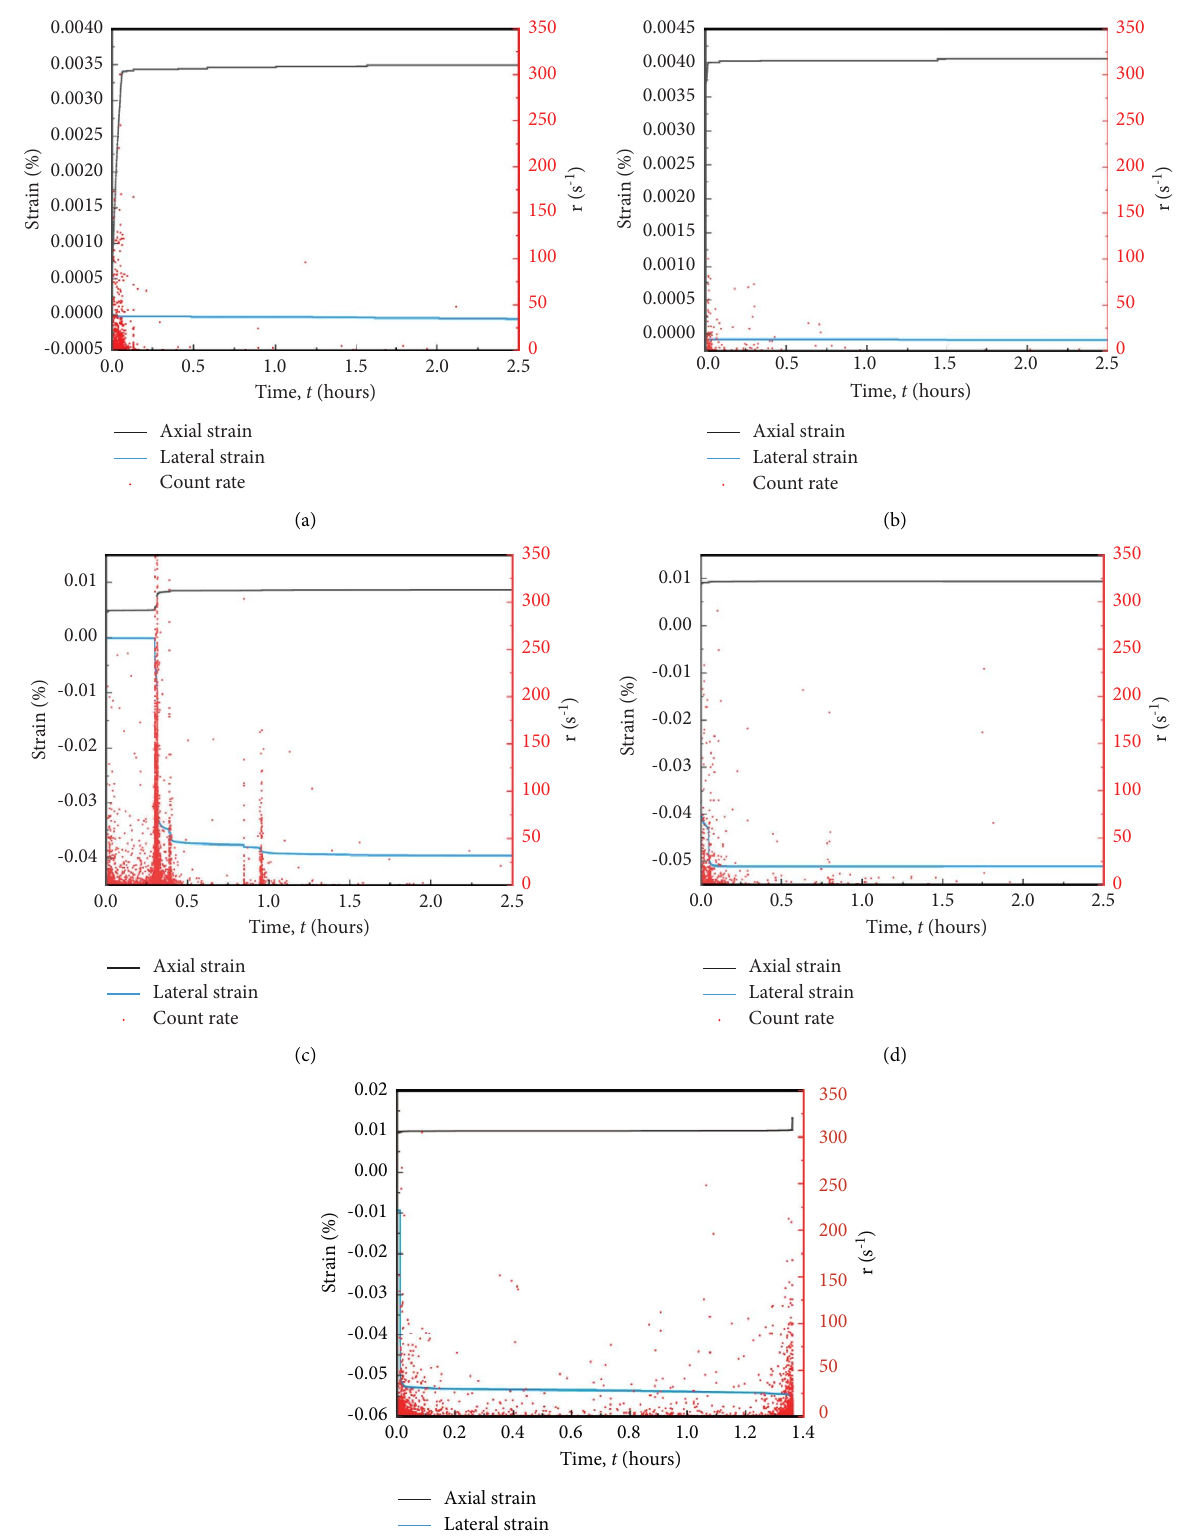
Figure 11: Te relationship between the loading time, strain, and AE signals of the sample after oil erosion at each loading stage. (a) 0.4 σ (b) 0.5 σ . (c) 0.6 σ . (d) 0.7 σ . (e) 0.8 σ ucs ucs ucs ucs